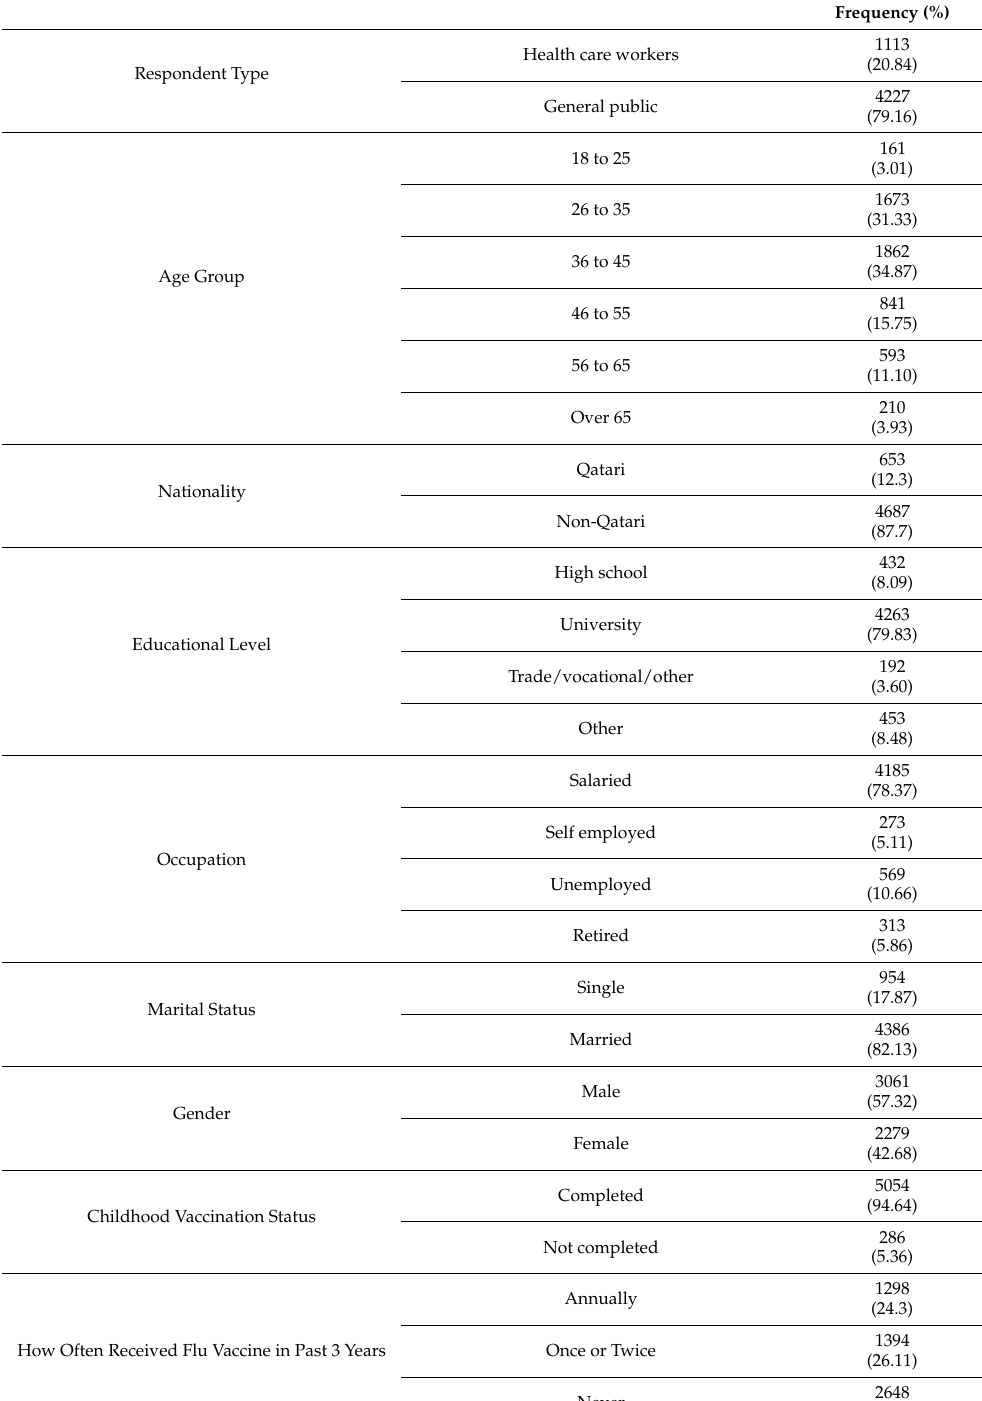
Table 1. Sociodemographic and contextual data of the participants for COVID-19 vaccine hesitancy in